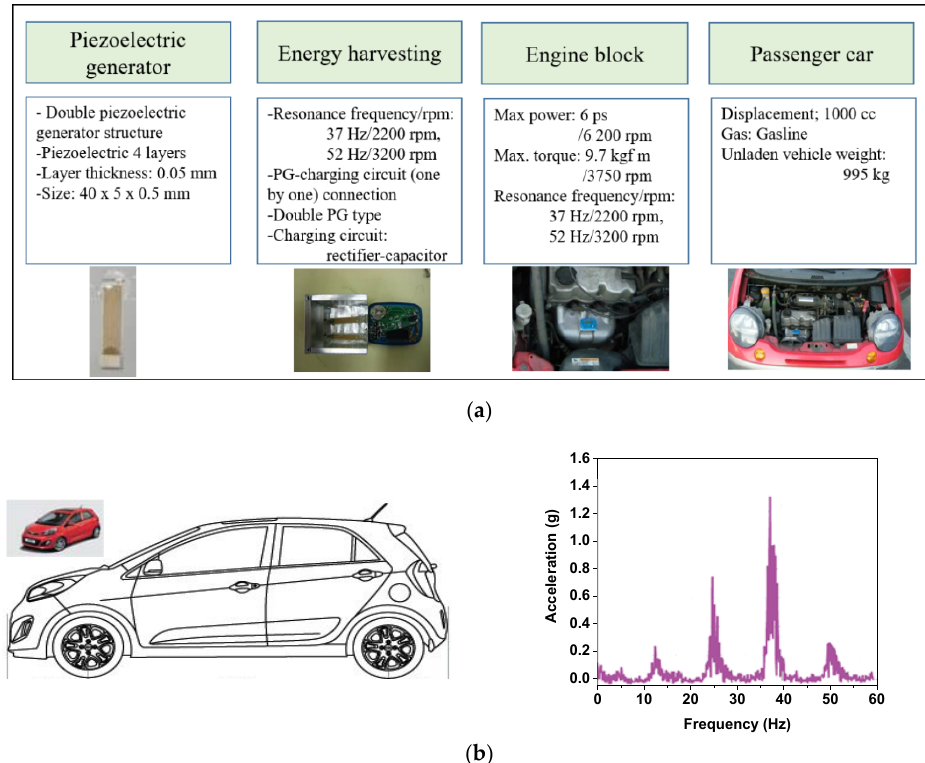
Figure 2. Schematic illustrations of the piezoelectric generator, its employment in the engine block of a small passenger car, and acceleration–frequency relationship of the engine block. ( a ) Specifications of piezoelectric generator, energy harvesting system, and engine blocks of the passenger car investigated in this study; ( b ) Schematic illustration of the passenger car and acceleration–frequency relation of the engine block (23~28 Hz: 1400~1800 rpm, 34~40 Hz: 2000~2400 rpm, 48~54 Hz: 2900~3300 rpm).